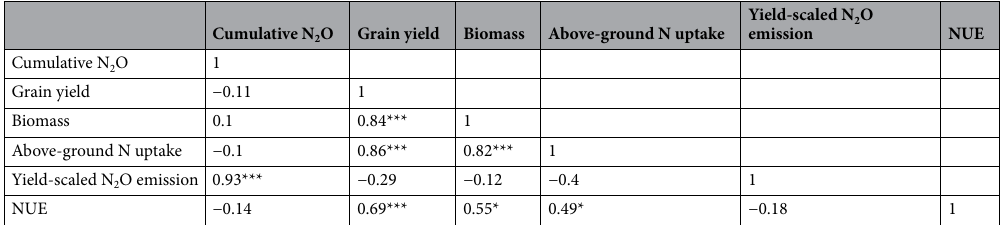
Table 3. Pearson correlation coefficients between Cumulative N 2 O, grain yield, biomass, Above-ground N uptake, Yield-scaled N 2 O emission and nitrogen use efficiency (NUE) in maize field at different rates of N and NI. * and *** Significant at P < 0.05 and P < 0.001,